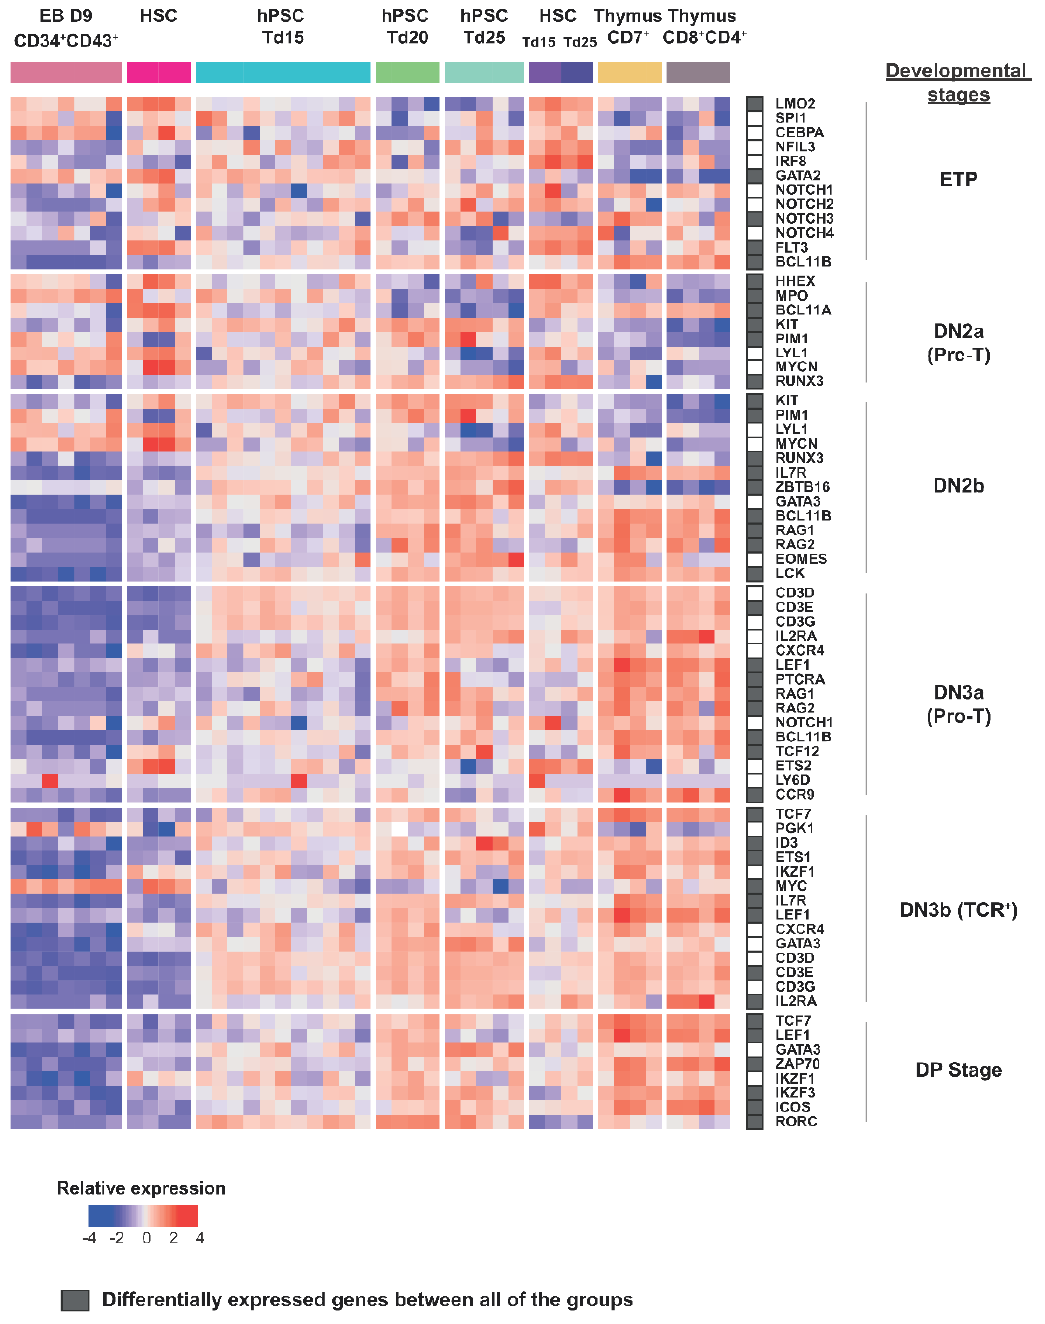
Figure 5. T-cell progenitors derived from hPSCs are stuck at the DN3a thymocyte stage. Gene expression heatmaps of selected markers associated with T cell development and function are shown as defined by DGE-seq. The heatmap was generated by scaling and center gene expression.